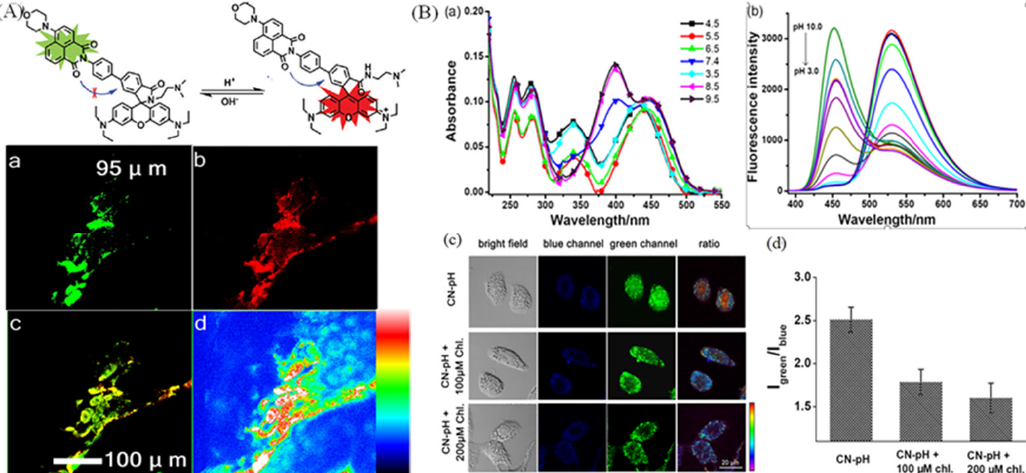
Figure 15. (A) Ratiometric response mechanism of lysosomal fluorescent probe NRLys to pH and the ratiometric imaging of mice muscle tissue slice. ( a ) Confocal pictures in green channel; ( b ) Confocal pictures in red channel. ( c ) Merged pictures of ( a ) and ( b ); ( d ) Ratiometric pictures of ( a ) and ( b ). Reproduced from [85] with permission of the American Chemical Society, copyright 2017. (B) Absorbance ( a ) and fluorescence ( b ) spectra of CN-pH in diverse pH solution, and the dual dolor images ( c ) of lysosomal pH changes in HeLa cells treated with 100 and 200 µM chloroquine. ( d ) The relevant ratios in ( c ).